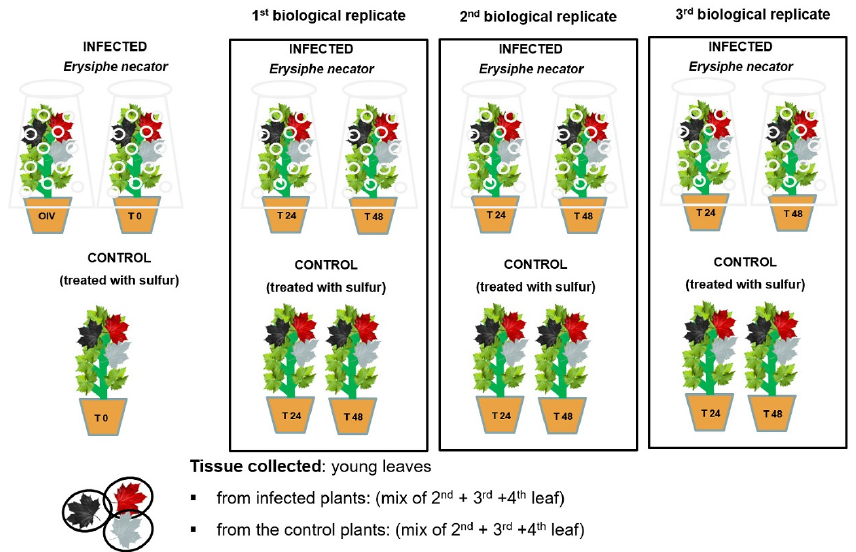
Figure 4. Randomization scheme of E. necator’ s inoculation and sample collection. The graph shows the three biological replicates, each with three time points (0, 24, and 48 hpi). Each biological replicate was divided in two groups: infected and control. The sample material collected was the second, third, and fourth leaf taken from each time point within each biological replicate, whereas the control was a mixture of the second, third, and fourth leaf taken from all the plants in a biological replicate.